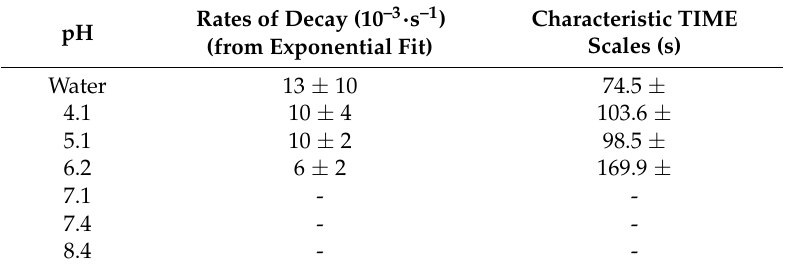
Table 1. Results obtained from single exponential decay fitting of loading kinetics in water and HBG buffer at pH 4.1 to 8.4. While the loading process is very fast in water, in buffers with defined pH values rates of loading fall with rising pH, and no loading is detectable at pH 7.1 or higher.